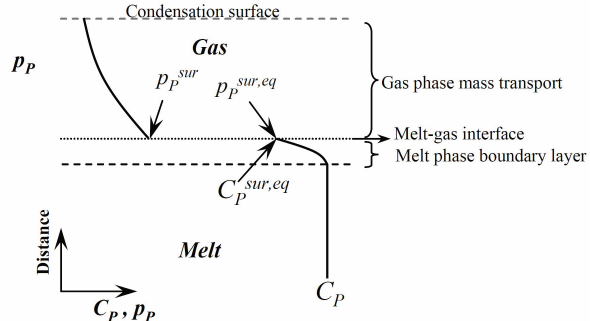
Figure 6. The mass transfer of phosphorus from silicon melt to the gas phase through a three step mixed control